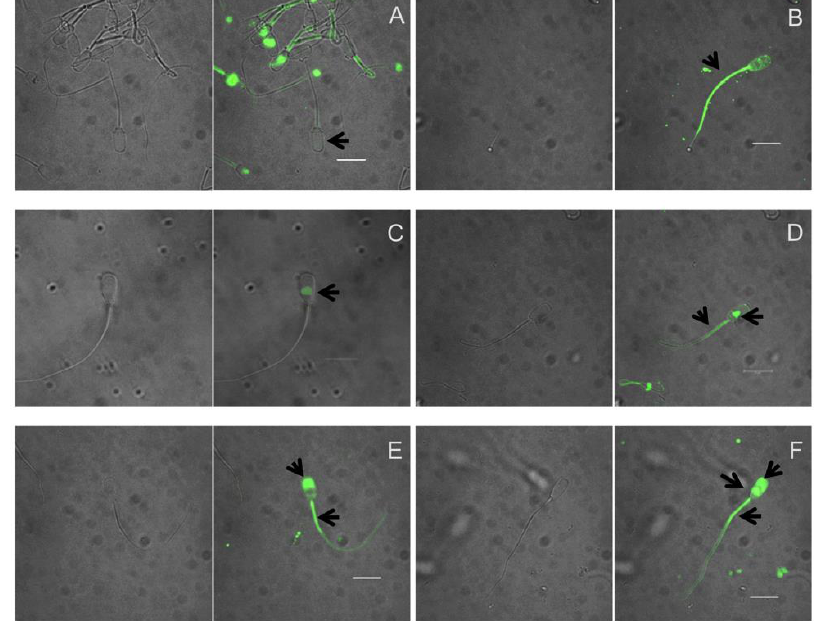
Figure 3. Fluorescence micrographs of various phosphorylation patterns in tyrosine residues of boar sperm capacitated in vitro, the fluorescence was granted by the use of fluorophore Alexa 488. Six different patterns were found, ( A ) No fluorescence. ( B ) Fluorescence in flagellum. ( C ) Fluorescence in equatorial segment. ( D ) Fluorescence in equatorial segment and flagellum. ( E ) Fluorescence in acrosome and flagellum. ( F ) Fluorescence in acrosome, equatorial segment and flagellum. Patterns were classified as: no fluorescence on head (NFH), fluorescence in acrosome (AF), equatorial head segment (EF), and acrosome plus equatorial head segment (AE). — , 1 µm.